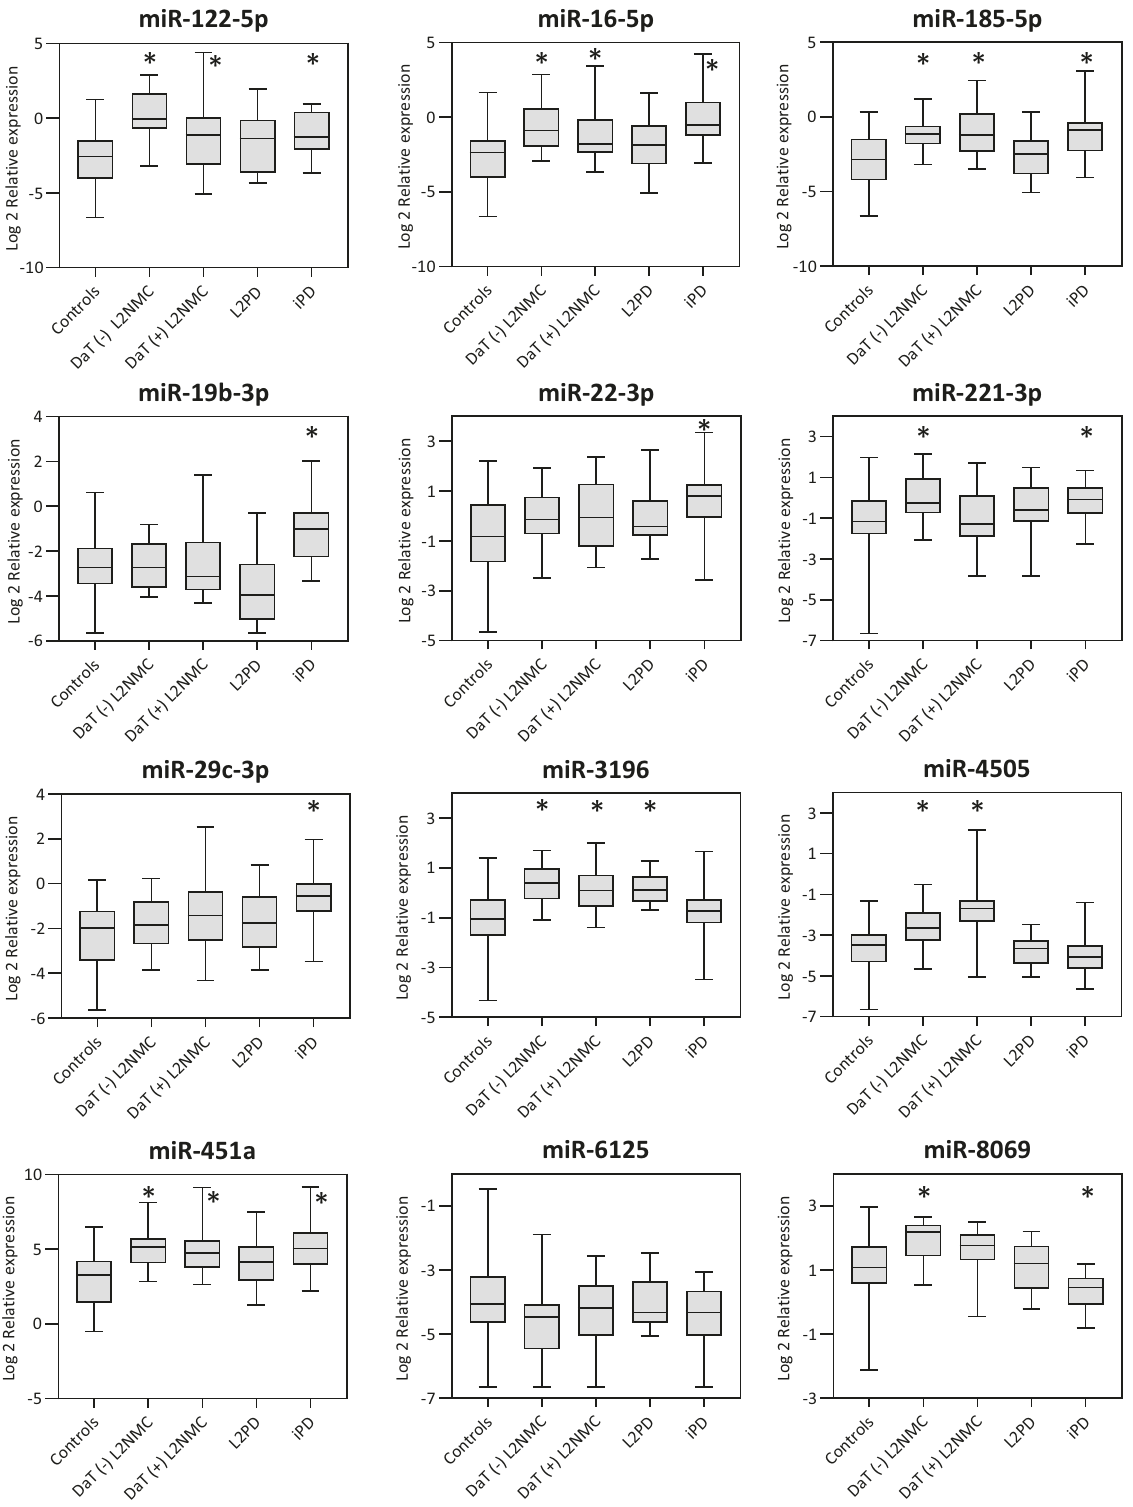
Fig. 3 Relative serum miRNA expression levels in DaT-negative L2NMC, DaT-positive L2NMC, L2PD, iPD and controls as assessed by RT-qPCR. The central line of the boxes is plotted at the median, the boxes extend from the 25th to the 75th percentiles, and the whiskers extend to the minimum and maximum value. (*) depicts statistically signi fi cant DEmiR with fold-change difference above |1.5| and a multiple- test adjusted p value below 0.05 under two-tailed Student ’ s t test. DaT DaT-SPECT imaging, L2NMC LRRK2 non-manifesting carriers, L2PD LRRK2-associated PD patients, iPD idiopathic PD